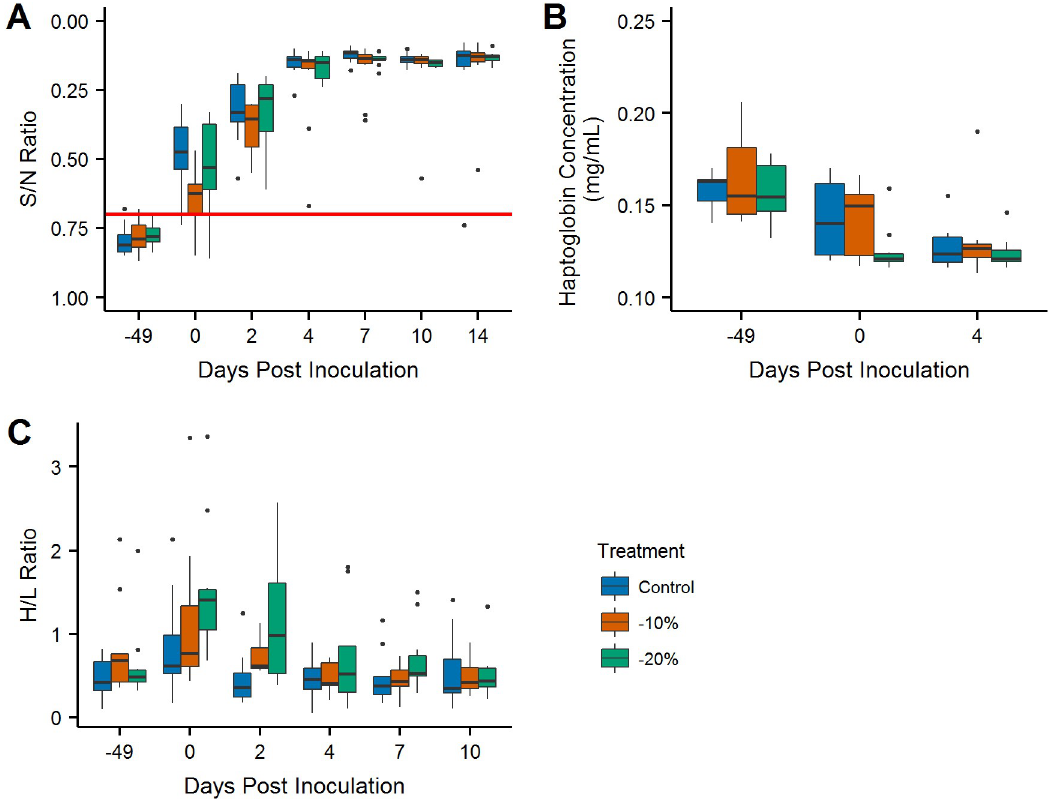
Fig 4. Immune Function. (A) Boxplots of the interpolatedS/N ratios over the durationof the study. Valuesabove the threshold S/N ratio of 0.7 (the red line) are considered positive for antibodiesto IAV. (B) Boxplots of haptoglobin concentrations over the durationof the study. (C) Boxplots of heterophil/lymphocyte ratios over the durationof the study.